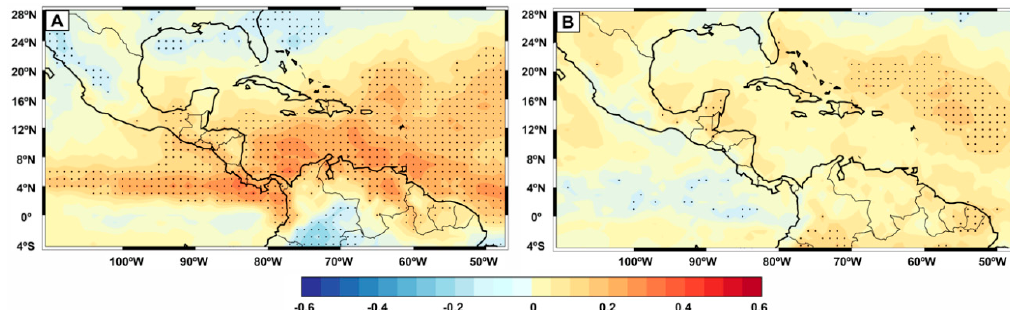
Figure 7. Correlation between the ( A ) Atlantic meridional mode (AMM) index and ( B ) NAO index computed with ERA–5 rainfall anomalies, with dotted areas indicating significant correlations p < 0.05. The blue shading shows areas in which positive AMM and NAO leads to rainfall reductions, while orange shading corresponds to regions that experience rainfall increases during positive AMM and NAO phases.